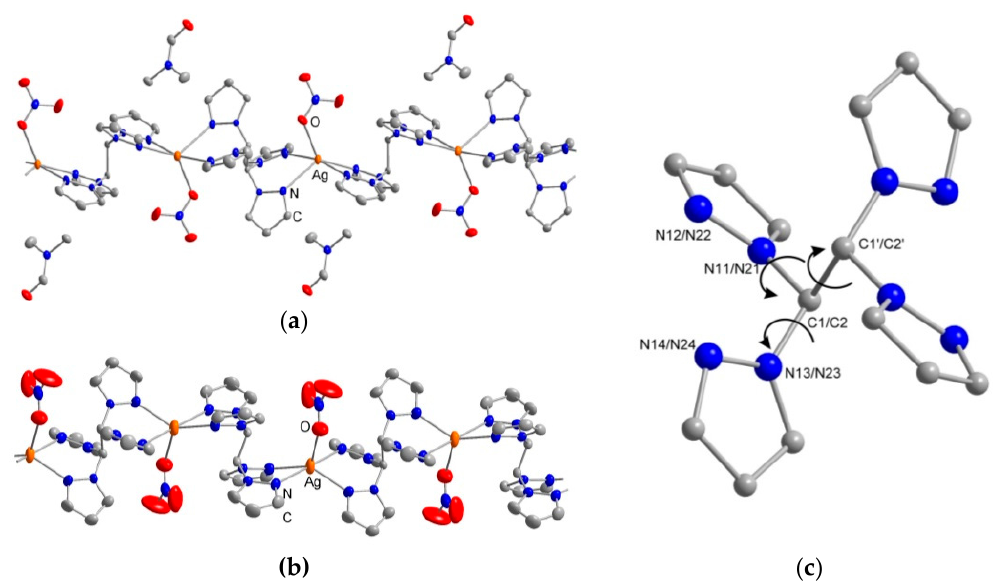
Figure 2. Thermal ellipsoid plots of complexes 1 ( a ) and 2 ( b ) showing 50% probability ellipsoids; ( c ) Atom numbering for compounds 1 and 2 and rotational modes of the Pz 4 . Hydrogen atoms have been omitted for clarity. Table 3. Addison’s τ 5 criteria for coordination centers in the complexes (1) and (2) .